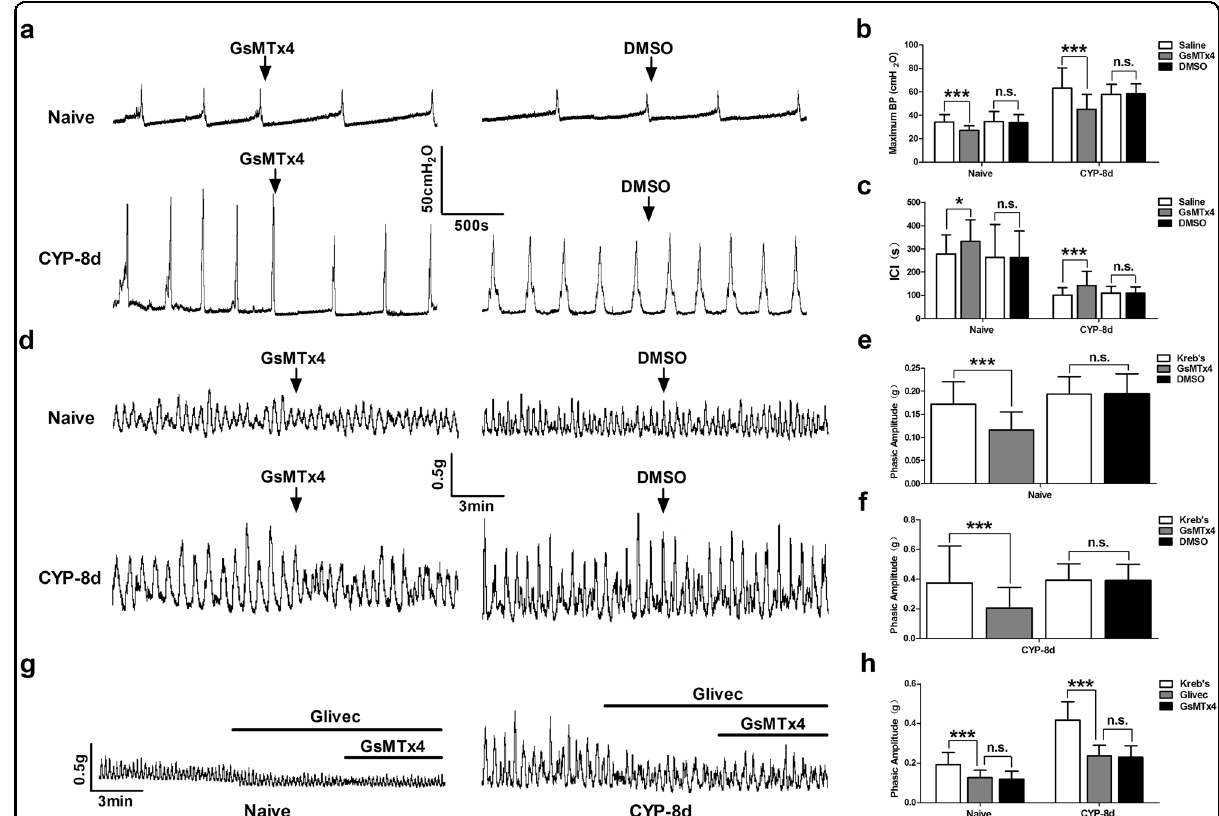
Fig. 3 Inhibition of the Piezo1 channel in bladder ICC-LCs by GsMTx4 signi fi cantly alleviated bladder hyperactivity in CYP-8d rats. a – c Compared with the vehicle (DMSO), 2.5 μ M GsMTx4 signi fi cantly decreased the MBP and prolonged the ICI in naive and CYP-8d rats, and naive rats showed lower sensitivity to GsMTx4 than CYP-8d rats (the data represent the mean ± S.D., n = 8; * P < 0.05, *** P < 0.001, and n.s., no signi fi cance, versus without drug administration). d – f In contractility studies, GsMTx4 had less of an inhibitory effect on the phasic amplitude of spontaneous contractions in isolated strips from naive rats than that in isolated strips from CYP-8d rats (the data represent the mean ± S.D., n = 6; *** P < 0.001, and n.s., no signi fi cance, versus without drug administration). g , h The c-kit blocker Glivec (100 μ M) signi fi cantly eliminated the effects of GsMTx4 on the phasic amplitude of spontaneous contractions in isolated strips from both naive and CYP-8d rats (the data represent the mean ± S.D., n = 6; *** P < 0.001, and n.s., versus Glivec